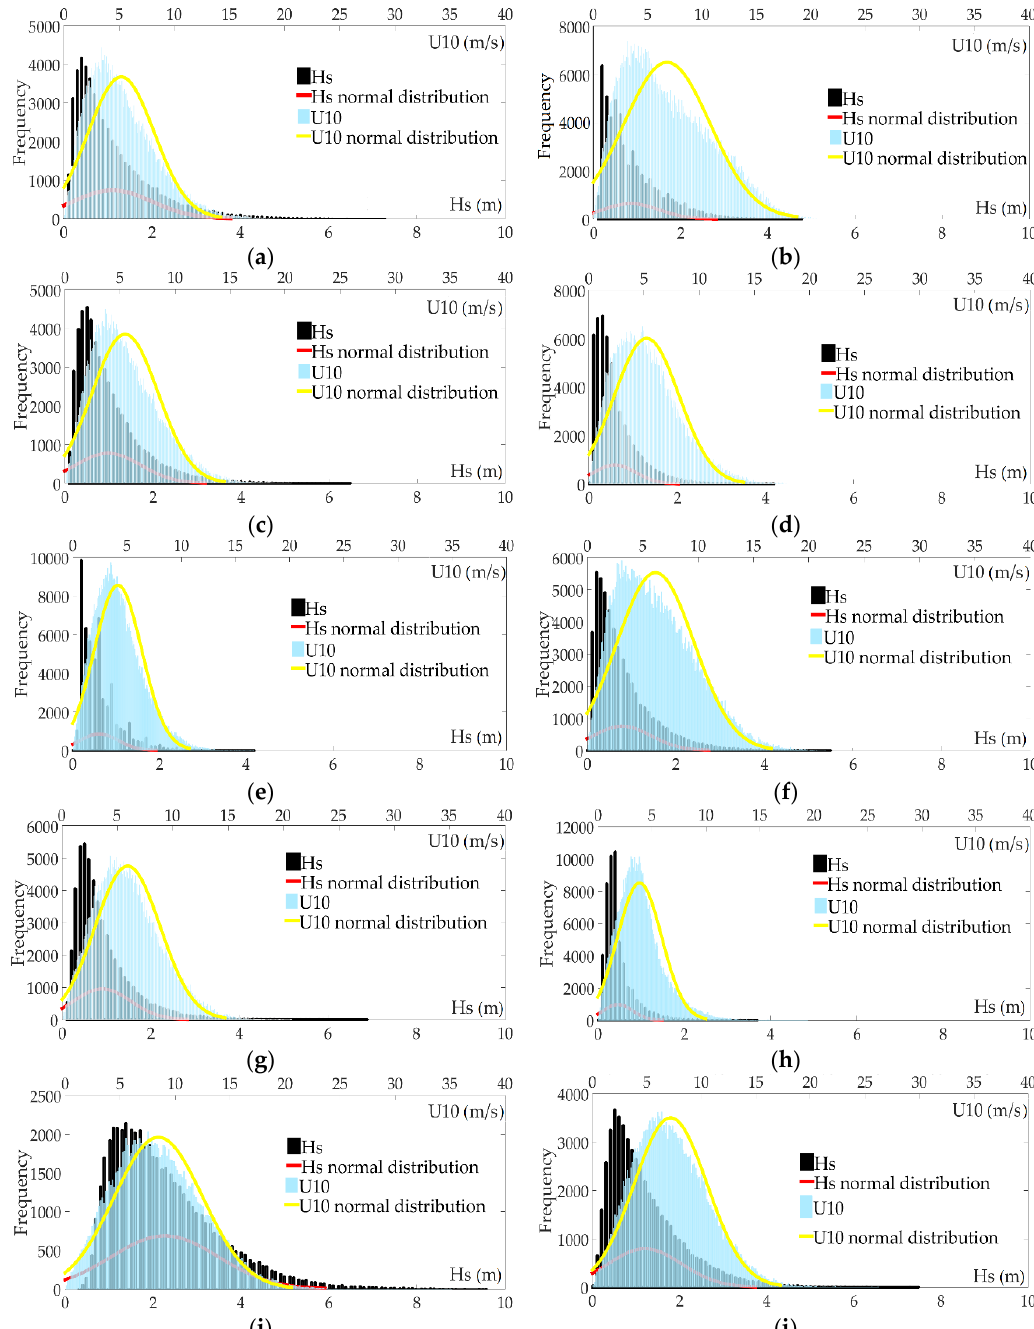
Figure 9. Representation of significant wave height (Hs) and wind speed histograms (U10) in comparison with the normal distribution for ten of the most representative points: ( a ) A3; ( b ) B1; ( c ) C4; ( d ) D3; I E3; ( f ) F1; ( g ) G1; ( h ) H2; ( i ) I1, and ( j ) J2.